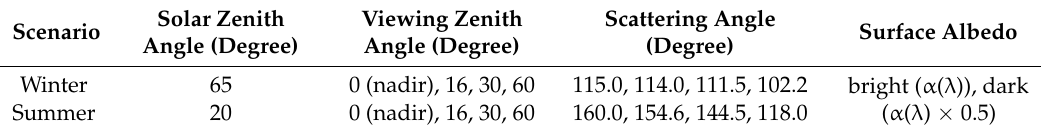
Table 3. Angles used in the simulation scenarios 1 .